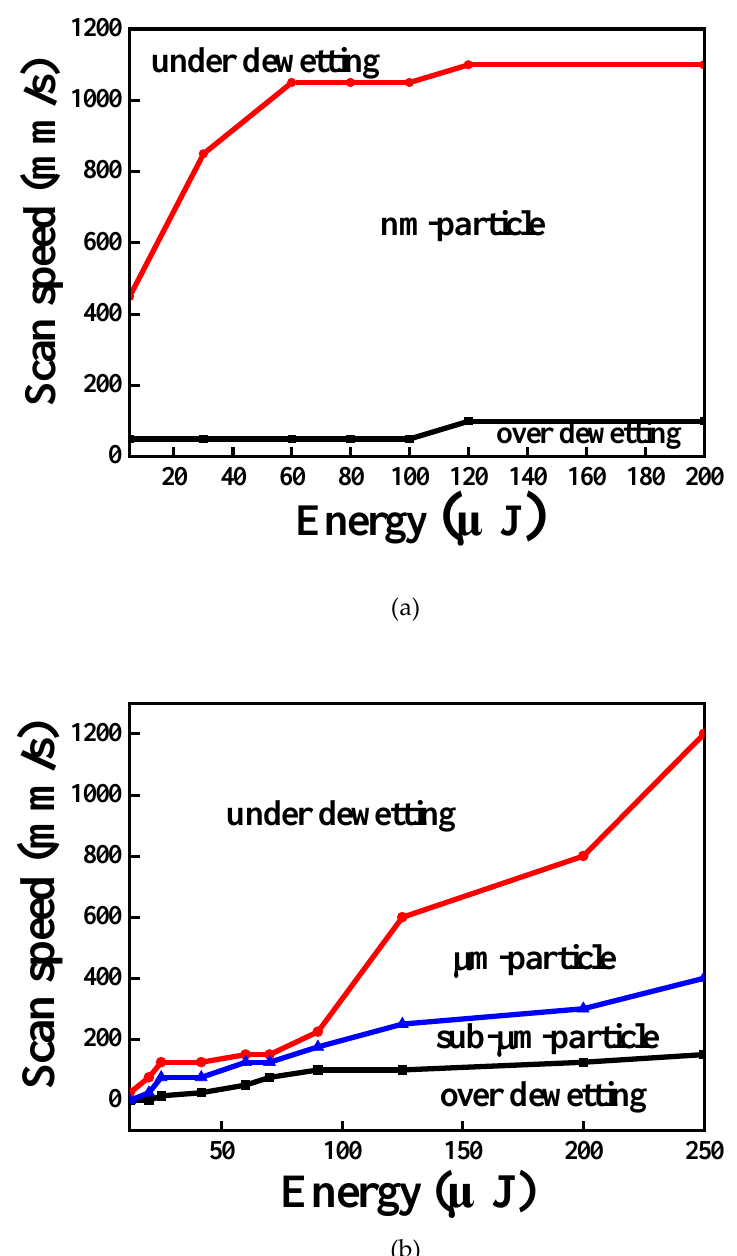
Figure 3. Relationship between scanning speed and laser input energy for initial Ag film thicknesses of ( a ) 10 nm and ( b ) 50